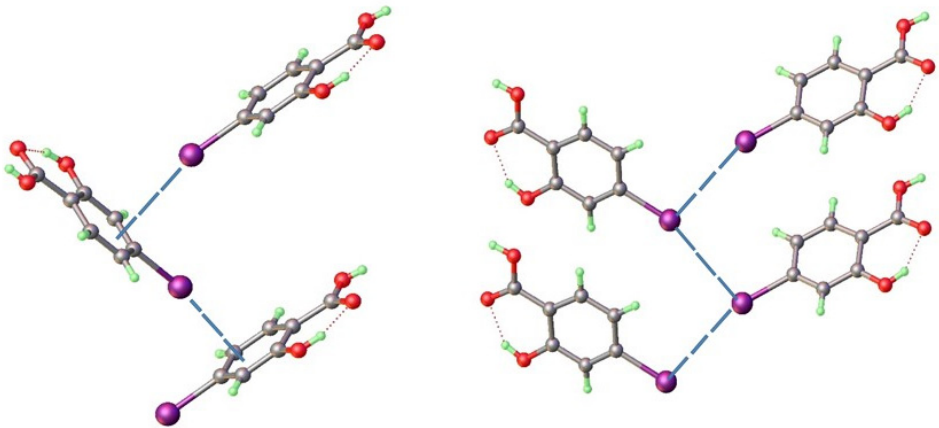
Figure 10. Closest iodo–iodo interactions are 4.668 Å in 4a ( left ) and 3.871 Å in 4b ( right ) respectively. Iodines in 4a form short halogen σ -hole- π interactions of 3.496 Å, shown by dashed line. In the type-I phases the shortest halogen—halogen distances are clearly non-bonding and